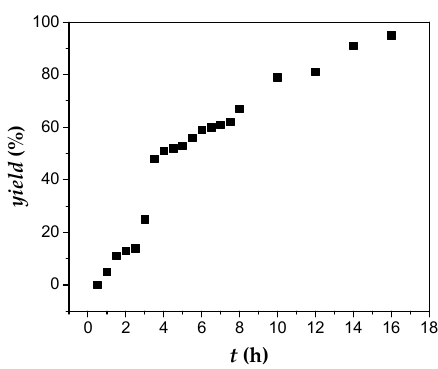
Figure 7. Polymerization of DCPD (0.6 mL, 552.0 mg, 4.2 mmol) with 1 (30.0 mg, 0.017 mmol), AgBF 4 (13.2 mg, 0.068 mmol) and 5.0 mL CH 2 Cl 2 ; % yield vs. time plot of PDCPD.